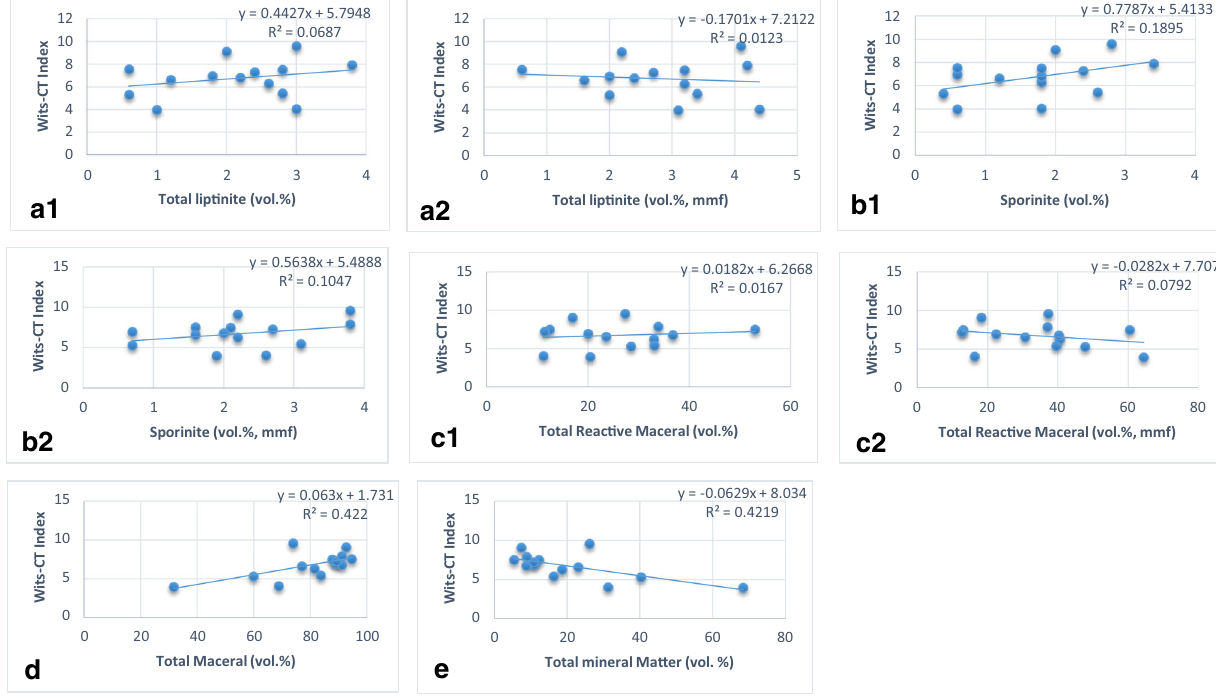
Fig. 14 Influence of liptinite, other macerals, petrographically observable mineral matter on spontaneous combustion of